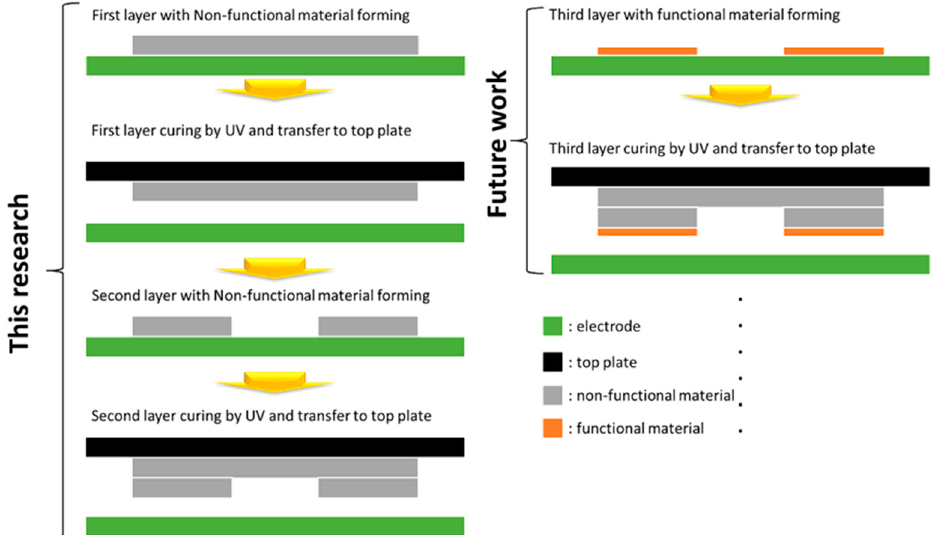
Figure 12. Current 3D structure fabrication flow in this research and application in functional material with DEP systems for structural electronics in the future.